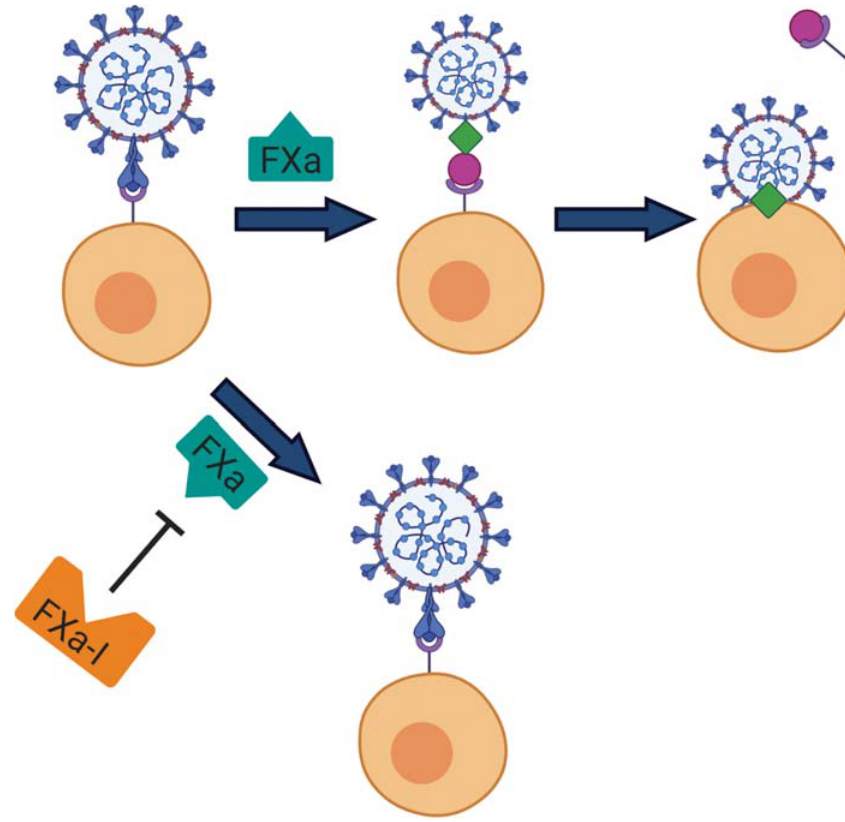
Fig. 3 Proposed therapeutic mechanism of factor Xa inhibitor on CoVcellular infection. (Top) SARS coronavirus binds to the host cell expressing a receptor (purple) that binds tothe SARS coronavirus spike protein (blue club-shape). Factor Xa (FXa) then acts as a proteolyticenzyme, cleaving spike protein into spike protein 1 (pink circle) and spike protein 2 (green diamond). The spike protein 1 then parts from the virus – cell complex withor without theattachedreceptor, while spike protein2servesto aidin thefusionof the virus andcell membranes.(Bottom) Theadditionof a factor Xa inhibitor (FXa) blocks FXa from acting as a proteolytic enzyme, therefore leaving the spike protein intact and preventing virus and host cell membrane